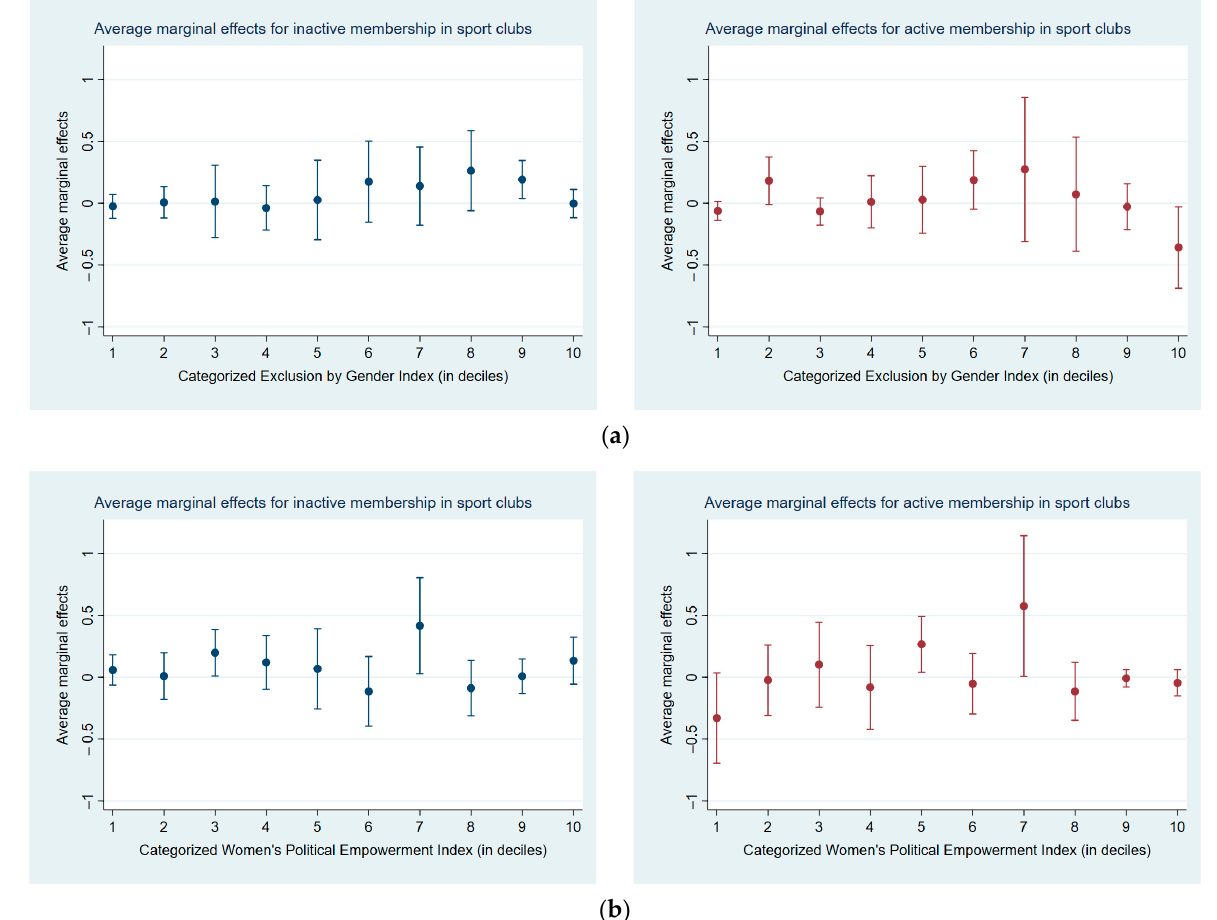
Figure 7. Average marginal effects for active and inactive membership in sports clubs ( a ) conditioned on the deciles of the Exclusion by Gender Index or ( b ) conditioned on the deciles of the Women’s Political Empowerment Index for the group of women. We included 95% confidence intervals using robust standard errors. Source: WVS ‐ EVS data and V ‐ Dem data.